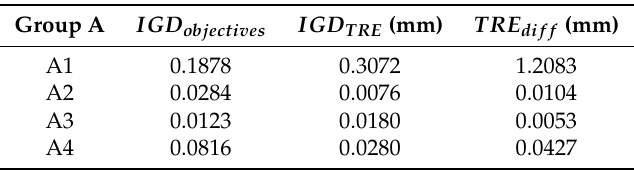
Table 2. IGD values for prone-supine Group A.